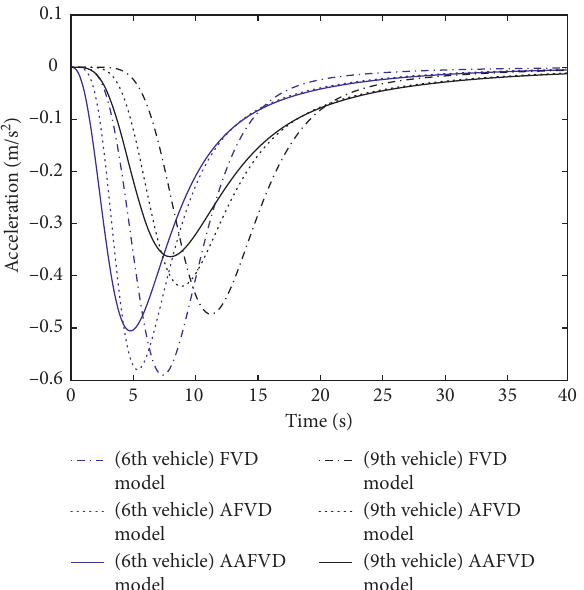
Figure 9: Comparison of two vehicles’ acceleration during the arrival process simulated by the FVD, AFVD, and AAFVD